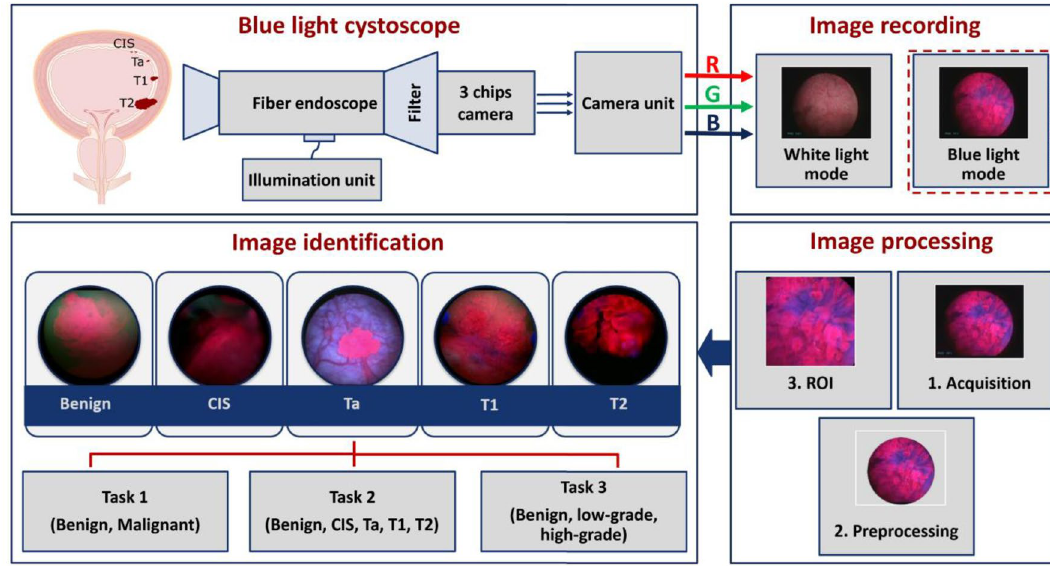
Figure 5. Overview of image acquisition and image processing using the blue light cystoscope.